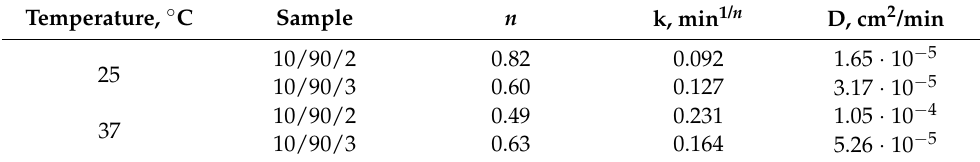
Table 1. Kinetic parameters of swelling of p(NiPMAm/NiPAm) hydrogels at pH 7.4. Temperature, ◦ C